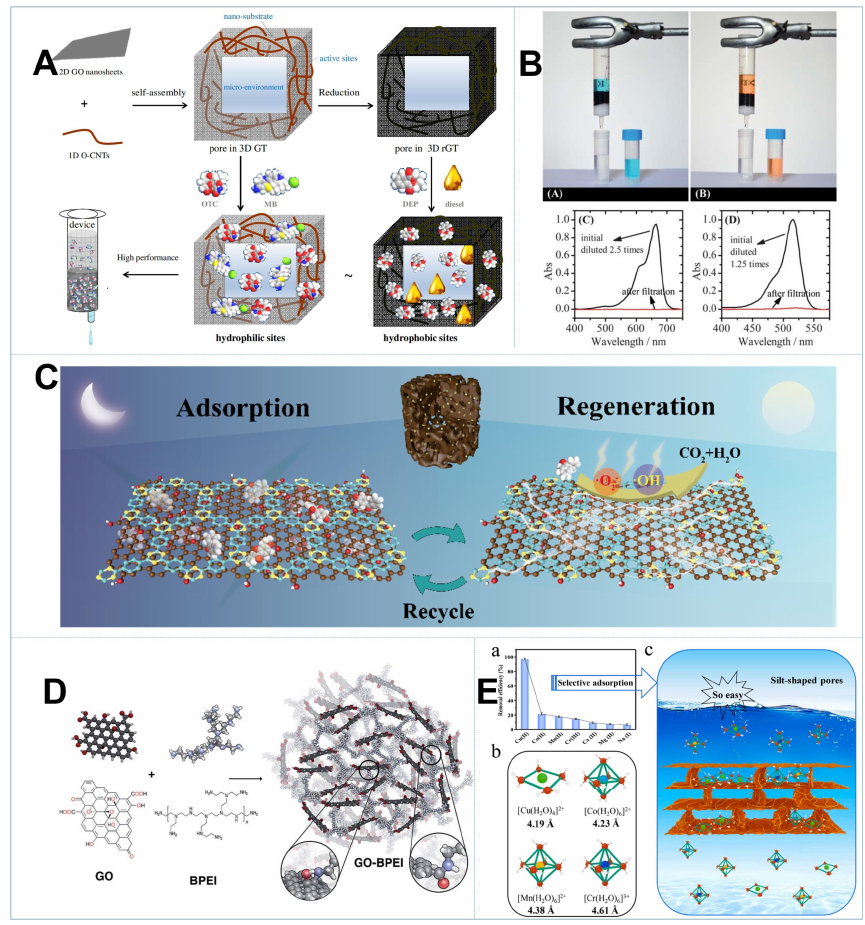
Figure 4. ( A ) The synergistic effect of GO and CNTs in 3D GTs’ structure and adsorption perfor- mance [98]. ( B ) Removal of MB and Eosin Y from water by filtration [110]. ( C ) Adsorption of trace organic micropollutants and regeneration under sunlight by 3D GO-CTF aerogel [116]. ( D ) Fab- rication of 3D GO-BPEI aerogel [119]. ( E ) Schematic illustration of selective removal of Cu(II) by Sr-G/M